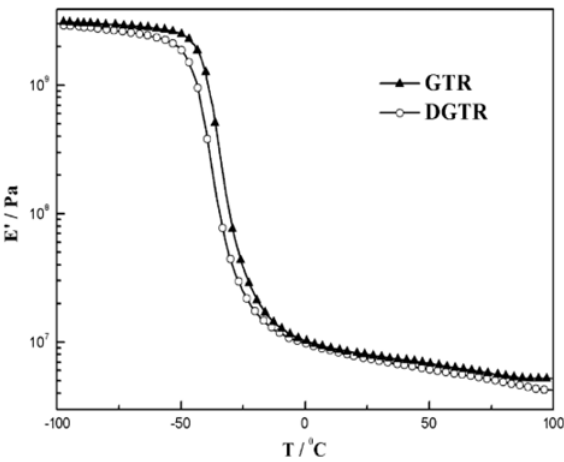
Figure 36. Storage modulus as a function of temperature for SBR / GTR and SBR / DGTR at 30 phr (reproduced with permission from